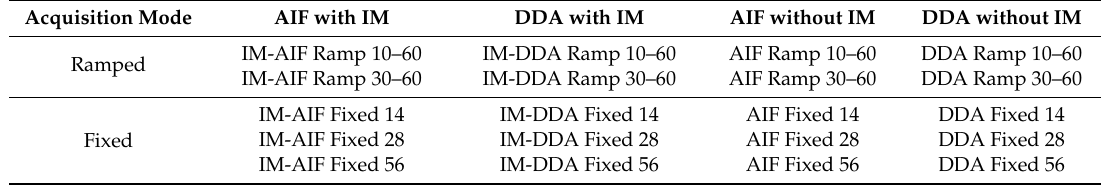
Table 1. All tandem MS acquisition modes used with and without ion mobility spectrometry